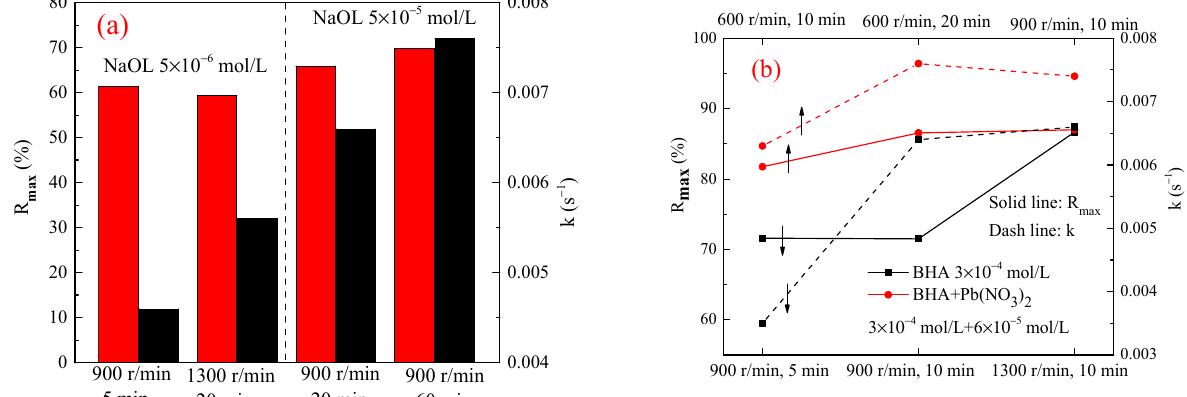
Figure 12. Fitting results of − 23 µ m cassiterite flotation rate experiments in the presence of NaOL ( a ) and BHA and Pb 2+ + BHA ( b ) under different stirring conditions.